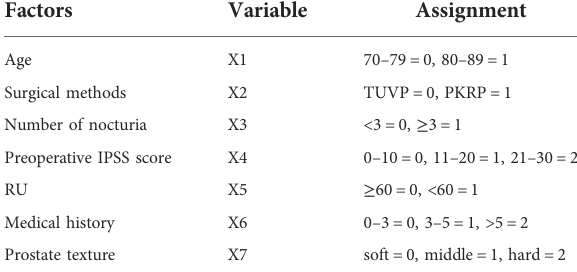
TABLE 4 Multifactor analysis assignment